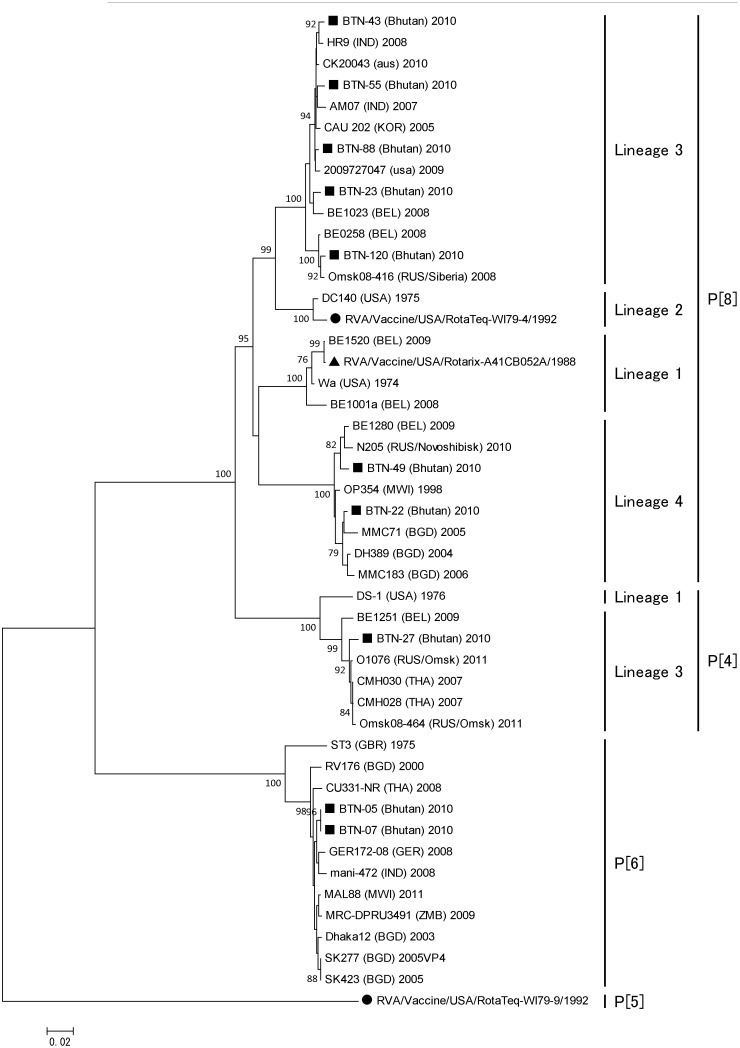
Phylogenetic tree constructed based on the deduced amino acid sequences of the VP8* genes of G1, G9, and G12 strains from Bhutan and global P[8], P[6], P[5], and P[4] strains.The species and country of origin are shown in parentheses after the strain name. The numbers adjacent to node represent the bootstrap values; values<70% are not shown. The scale bar shows the genetic distance, which is expressed as amino acid substitutions per site. The DNA Data Bank of Japan/European Molecular Biology Laboratory/GenBank accessions numbers are: AB905368 (rotavirus strain BTN-05), AB905369 (BTN-07), AB905370 (BTN-120), AB905371 (BTN-23), AB905372 (BTN-88), AB905373 (BTN-49), AB905374 (BTN-22), AB905375 (BTN-27), AB905376 (BTN-43), AB905377 (BTN-55).